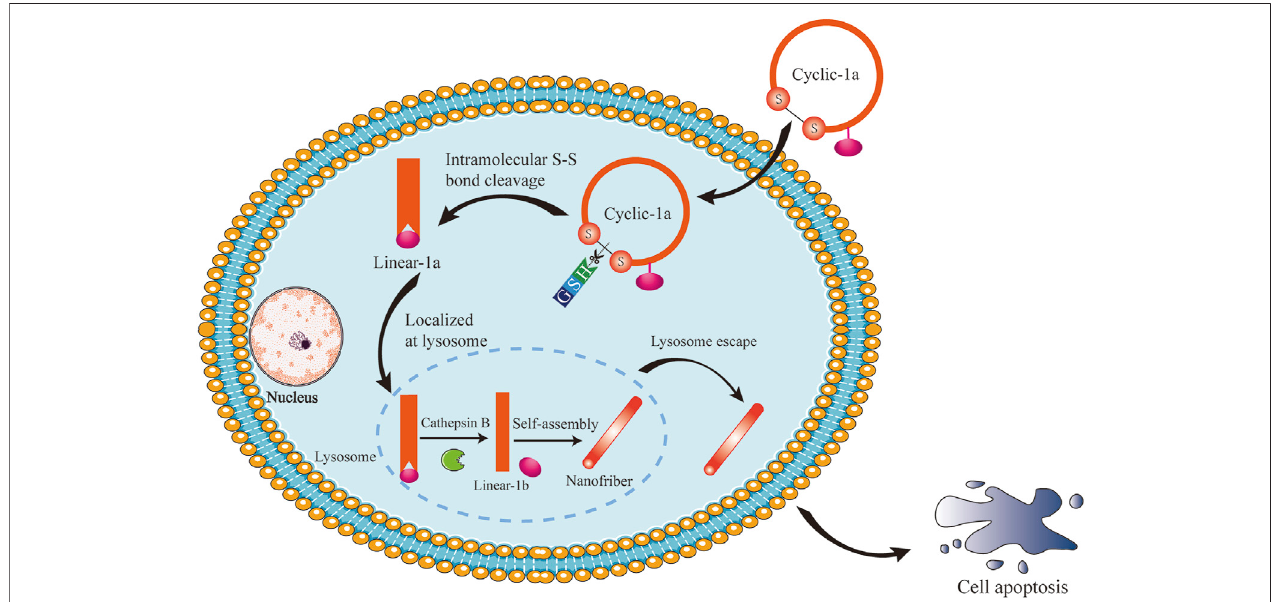
FIGURE 1 | Schematic illustration of intracellular GSH/CB dual-controlled self-assembly behavior of the cyclic peptide precursor that lead to apoptosis of DOX- resistant breast cancer cells.